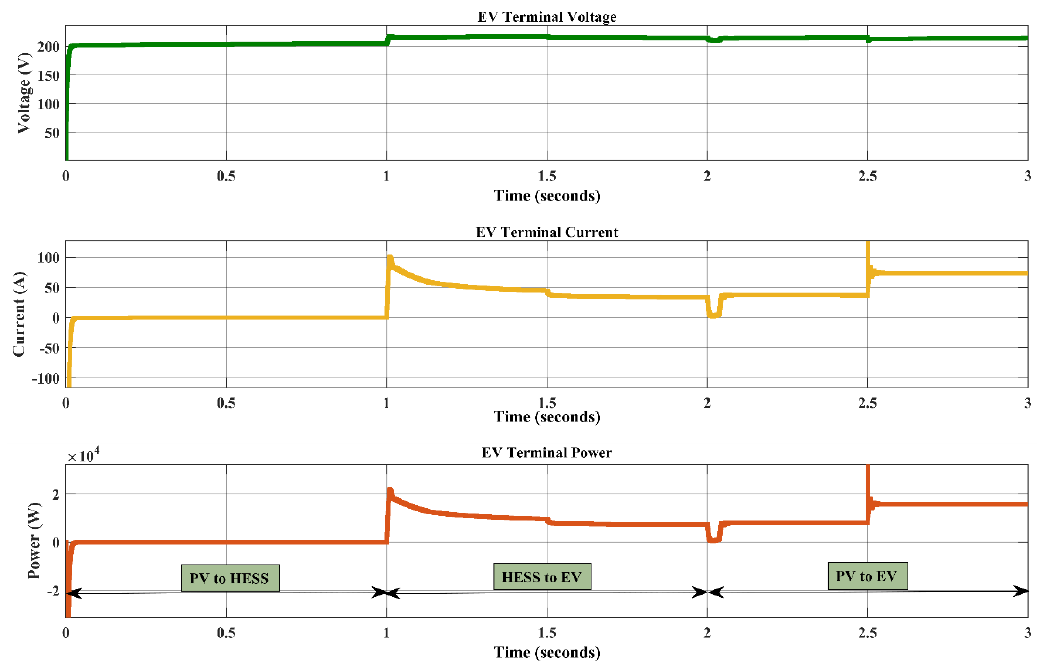
Figure 22. EV Terminal Voltage, Current, and Power different modes of operation.